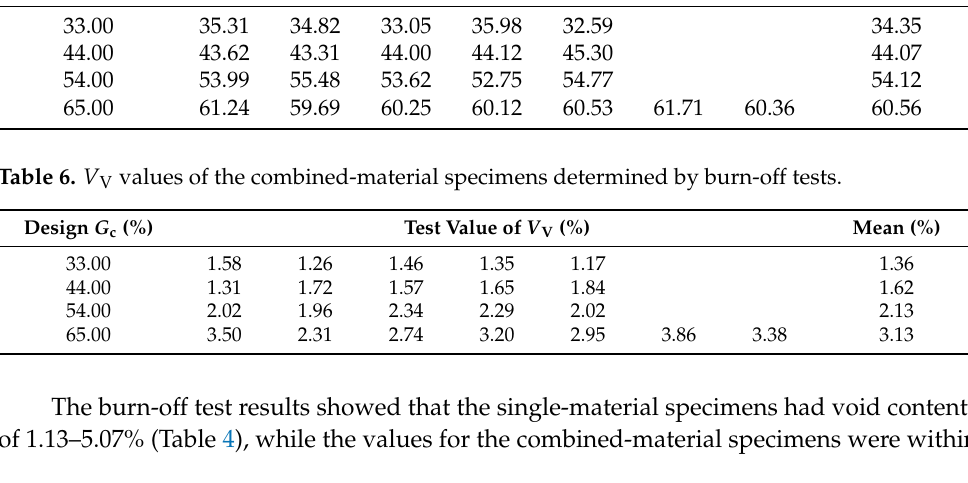
Table 5. Gc values of the combined-material specimens determined by burn-off tests. Design G c (%)